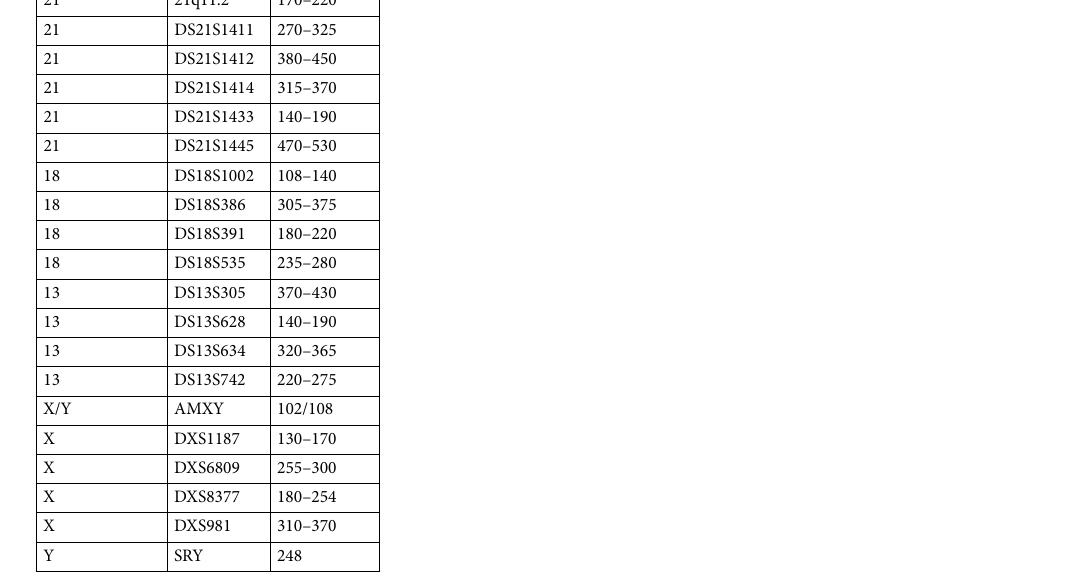
Table 7. STR markers analyzed by